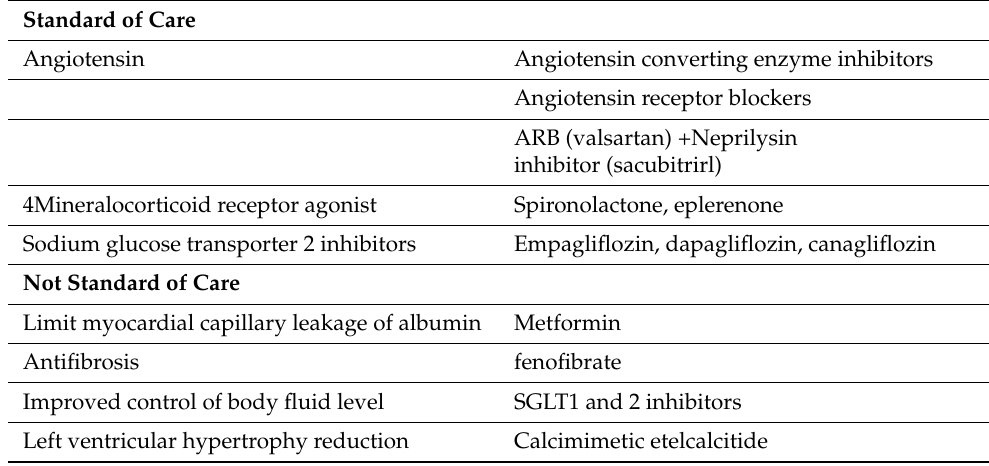
Table 5. Therapy in Cardiomyopathy of Diabetes with Hypertension +